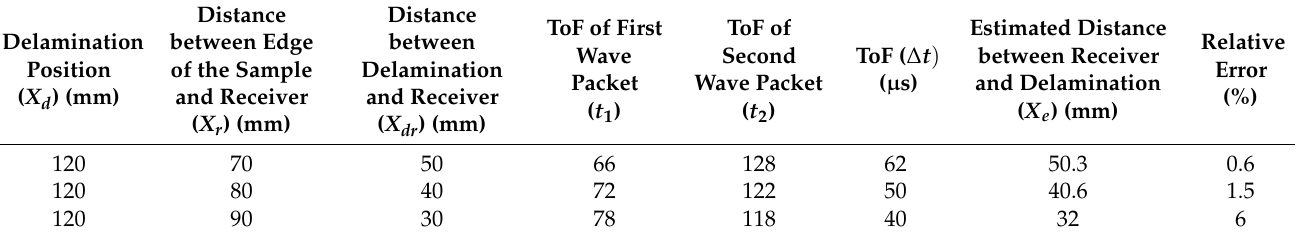
Table 7. The localization of delamination at 120 mm using CWT.